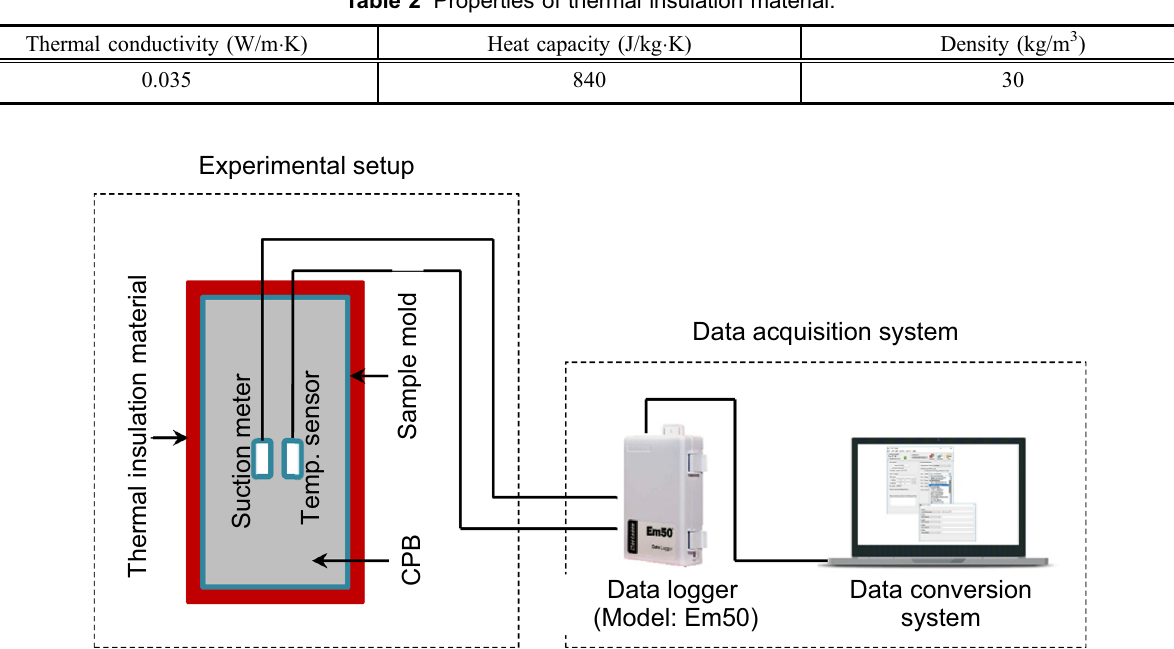
Fig. 6 Schematic diagram of experimental setup to test CPB strength under different initial temperatures.